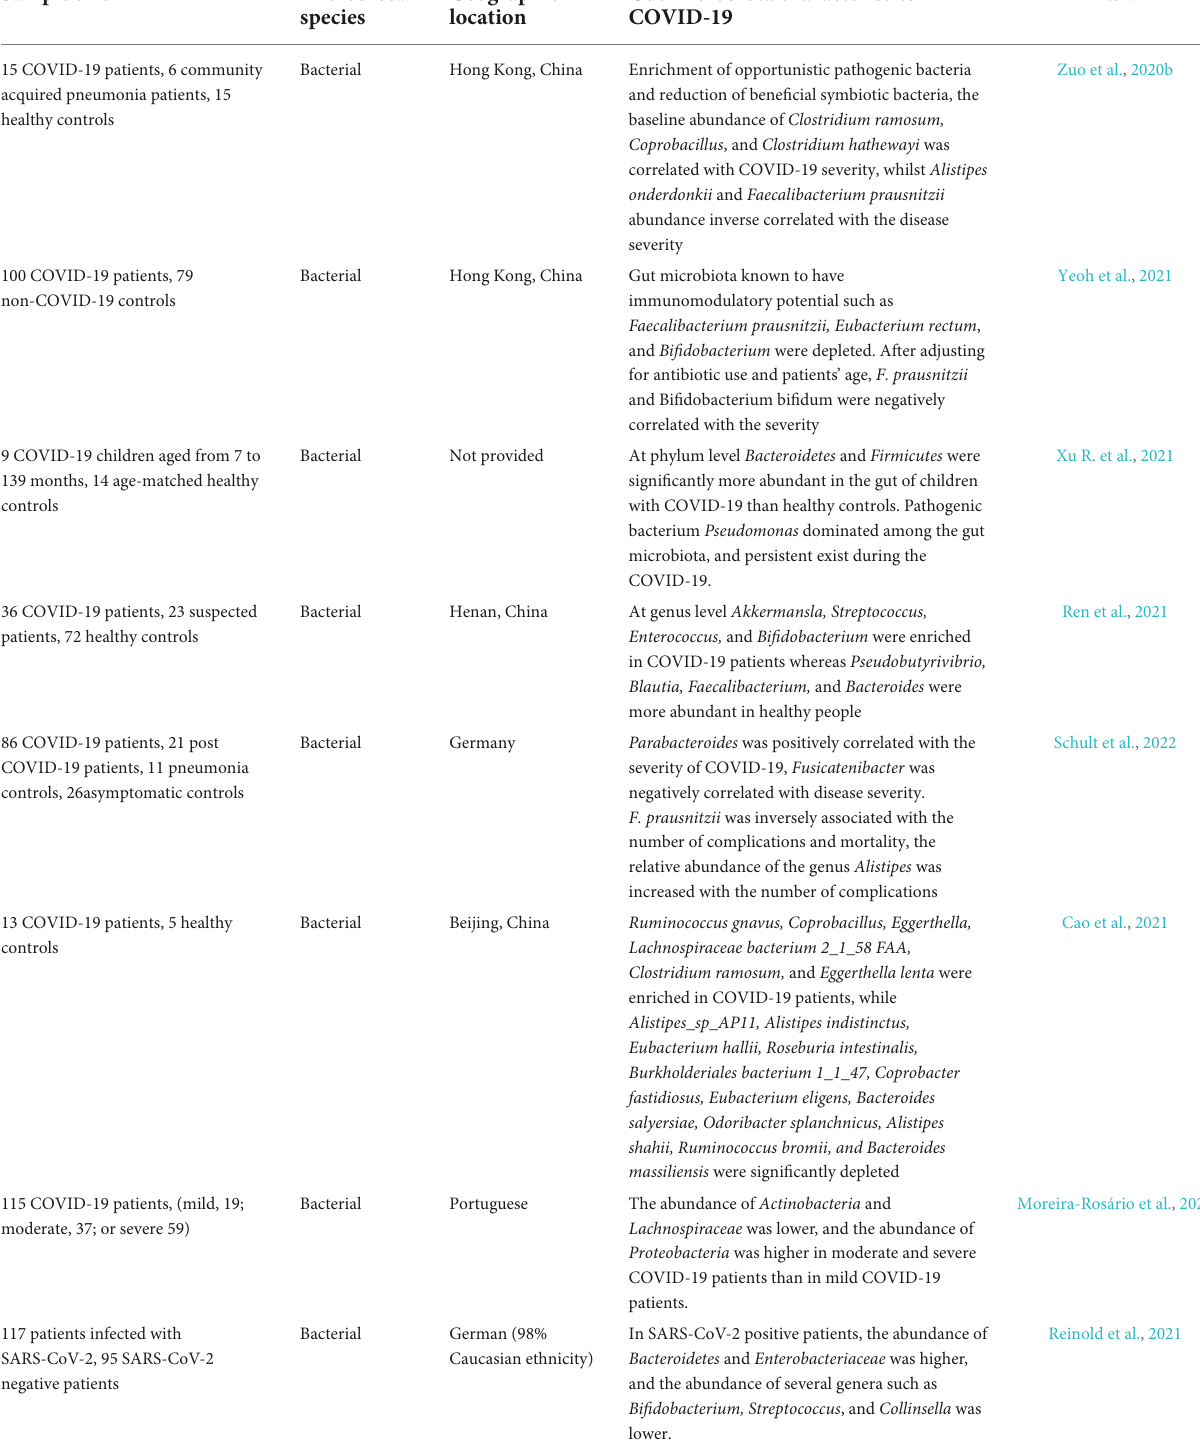
TABLE 1 The characteristics of gut microbiota in COVID-19